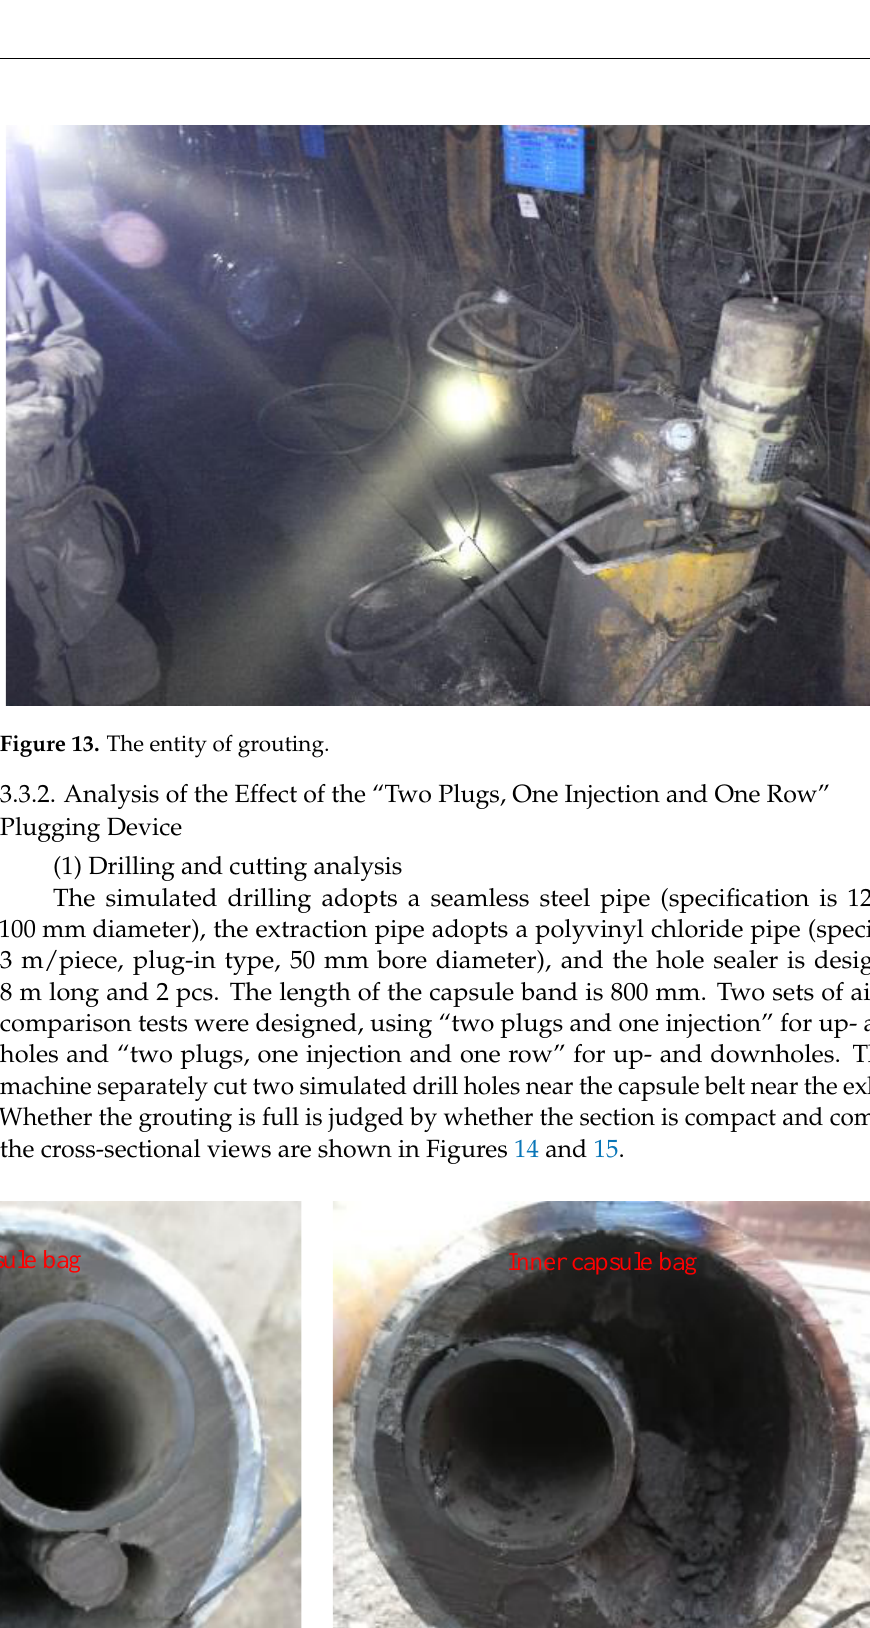
Figure 12. Schematic diagram of structures of hole packers for upward boreholes. 1 Extraction pipe; 2 grouting pipe; 3 grouting pipe; 4 mine drilling; 5 external blocking bag; 6 inner blocking bag; 7 metal clamp; 8 one-way valve; 9 burst valve.